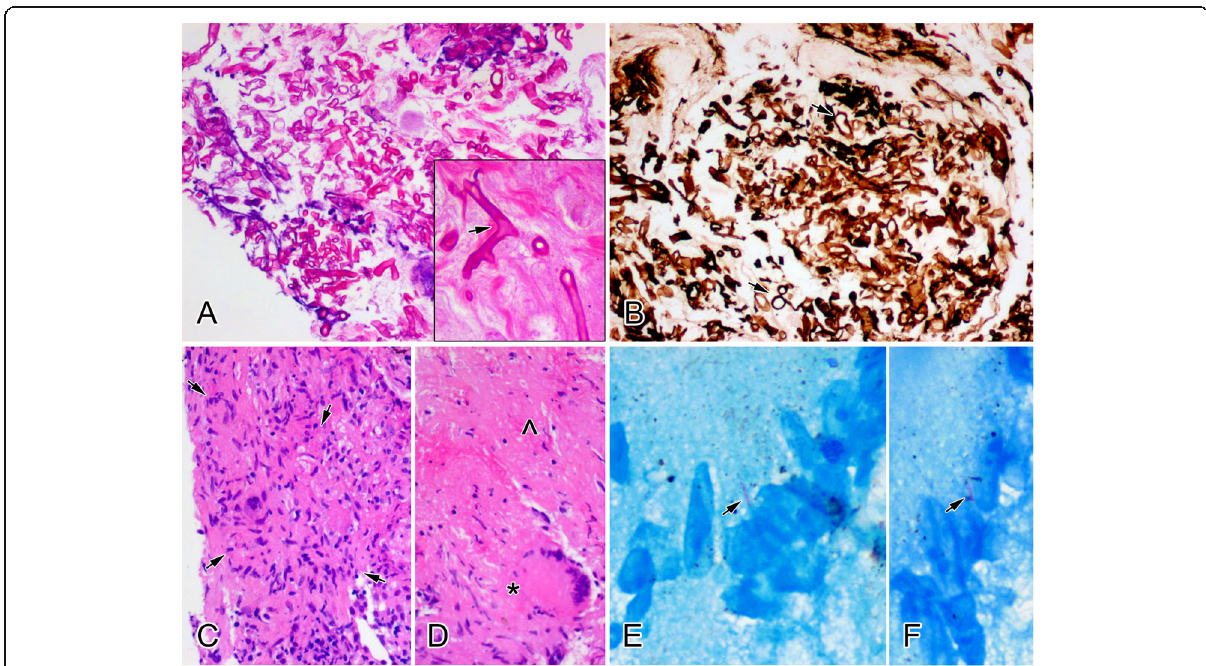
Fig. 2 Morphological manifestations of two representative cases with lymph node mucormycosis and tuberculosis, respectively. Broad, non- septate and thick-walled hyphae are seen with right angle branching (arrow), indicating mucormycosis ( a . H&E staining × 200). Cyst-like sections (arrows) of the Mucor hyphae are more prominent on staining of periodic acid-silver methenamine (PASM) ( b . PASM staining × 200). Aggregation with epithelioid cells (inside arrows,) is present ( c . H&E staining × 400), accompanied with typical Langerhans giant cells (*) and caseous necrosis (^), indicating tuberculosis ( d . H&E staining × 400). Positive bacilli (arrows) of acid-fast staining are found ( e , f . acid-fast staining × 400)